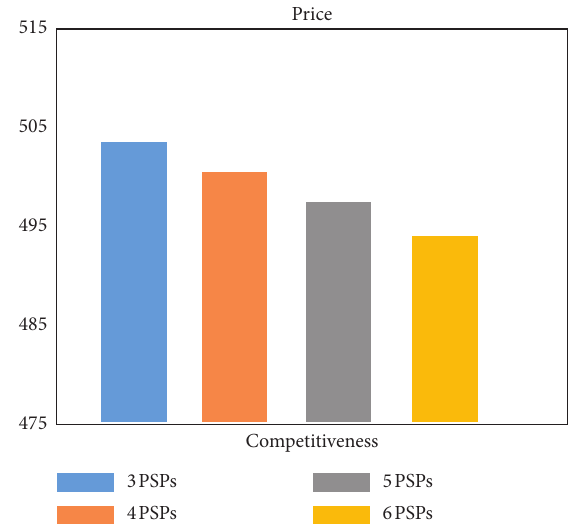
Figure 6: Price under different numbers of PSPs.